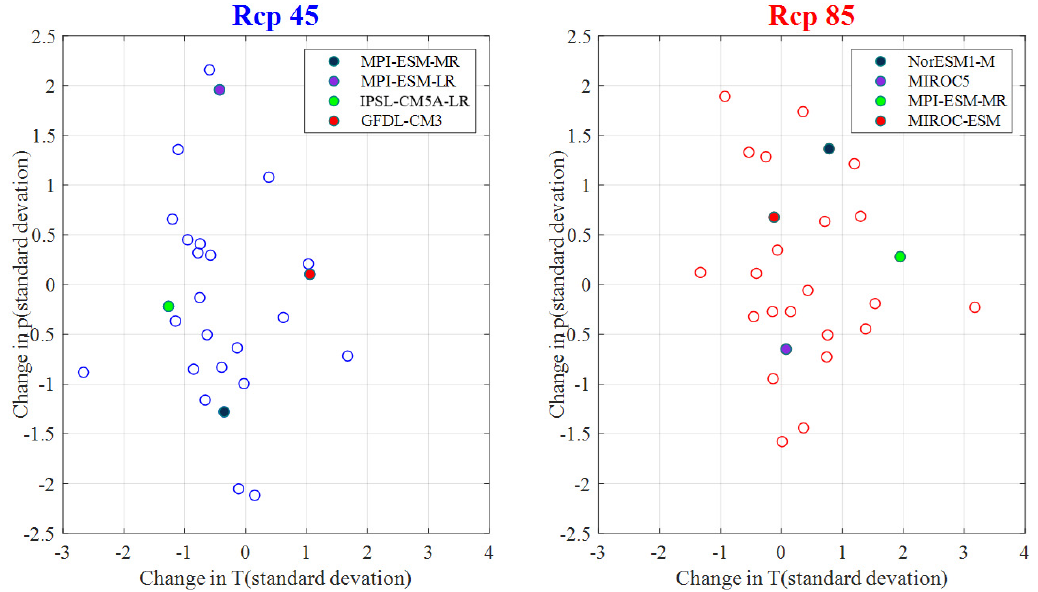
Table 2. Seven General Circulation Model simulations’ details of CMIP5.